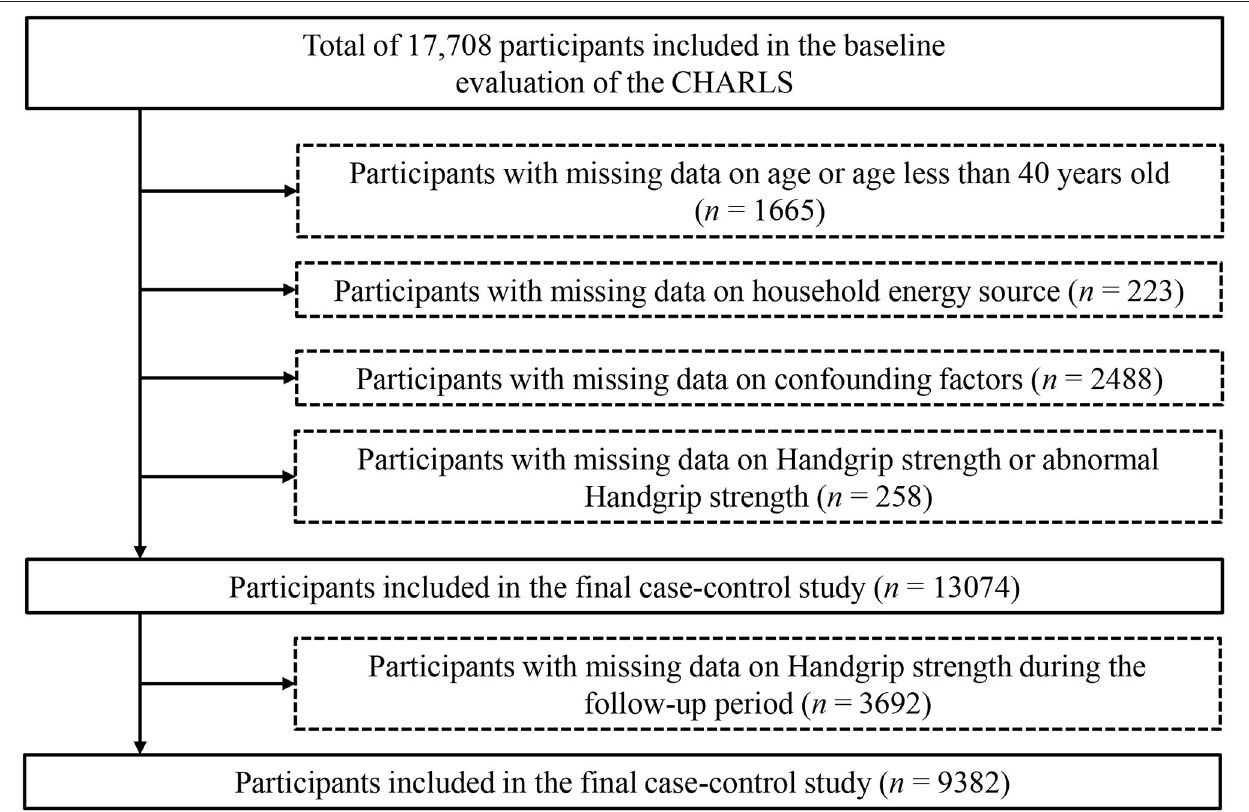
FIGURE 1 | Flow chart of the selection process of participants. CHARLS, China Health and Retirement Longitudinal